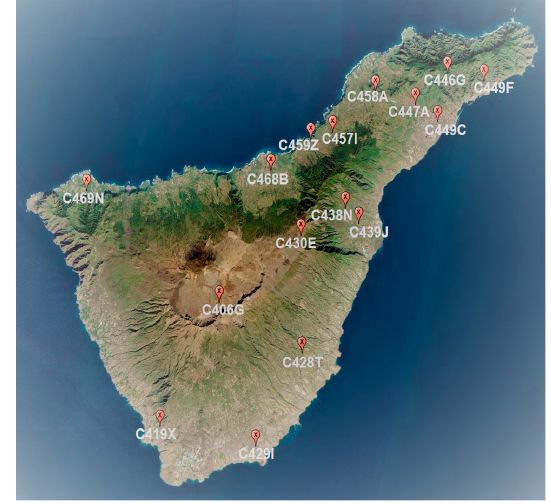
Figure 4. Main weather stations on Tenerife island